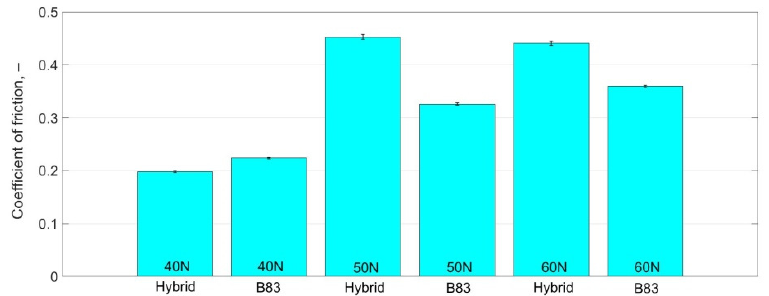
Figure 6. Coefficient of friction of the hybrid material and B83 babbitt with respect to different